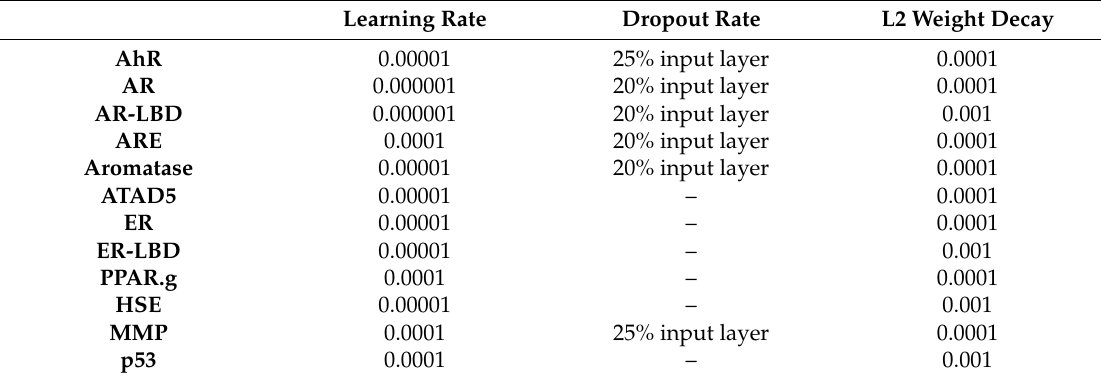
Table A1. Hyperparameter settings of 12